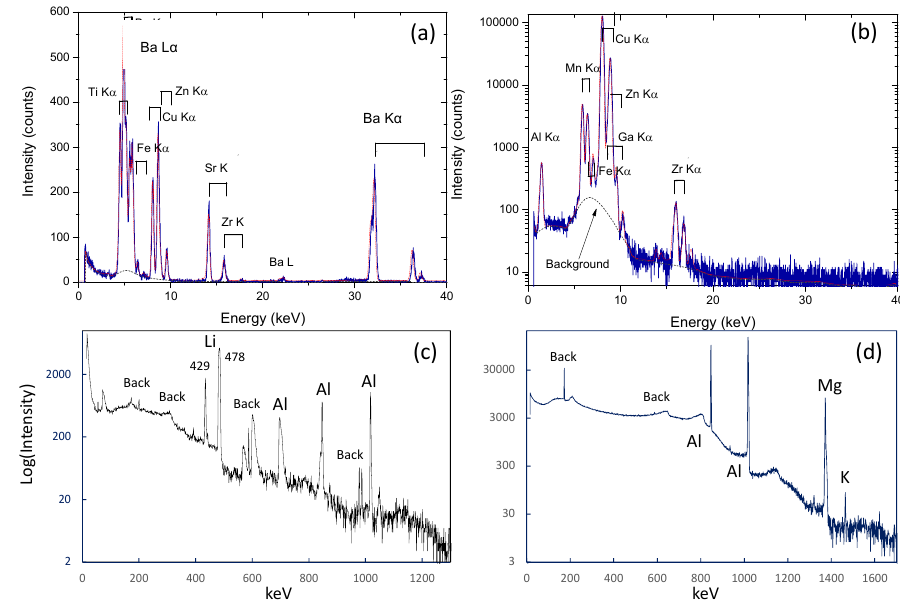
Figure 6. PIXE (X ‐ ray) spectra of the ( a ) primer and ( b ) AA2024 ‐ T3. Corresponding PIGE ( γ‐ ray) Figure 6. PIXE (X-ray) spectra of the ( a ) primer and ( b ) AA2024-T3. Corresponding PIGE ( γ -ray) spectra of the ( c ) primer and ( d ) AA2024 ‐ T3. The red lines in (a) and ( b ) are the fitted curves to the spectra of the ( c ) primer and ( d ) AA2024-T3. The red lines in (a) and ( b ) are the fitted curves to the spectra. The dashed lines in ( a ) and ( b ) are backgrounds used in the fitting. spectra. The dashed lines in ( a ) and ( b ) are backgrounds used in the